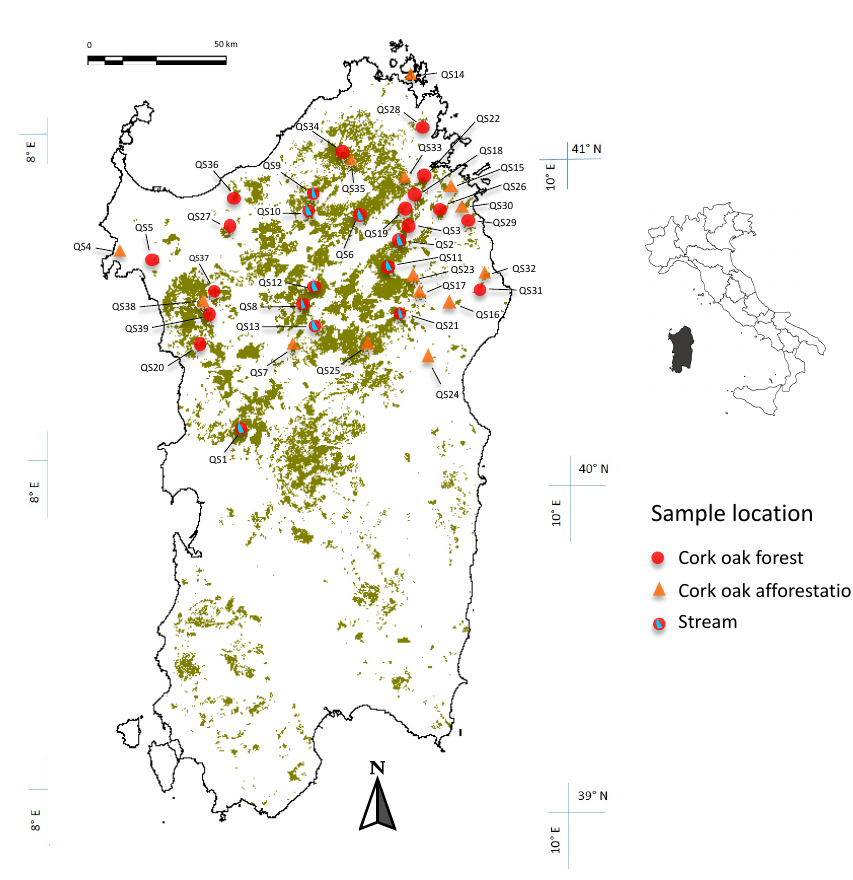
Figure 1. The geographic location of the 39 Quercus suber stands investigated in this study (QS1–QS39). The green area represents the geographic distribution of cork oak in Sardinia. A map of Italy is inserted into the top right corner showing the location of